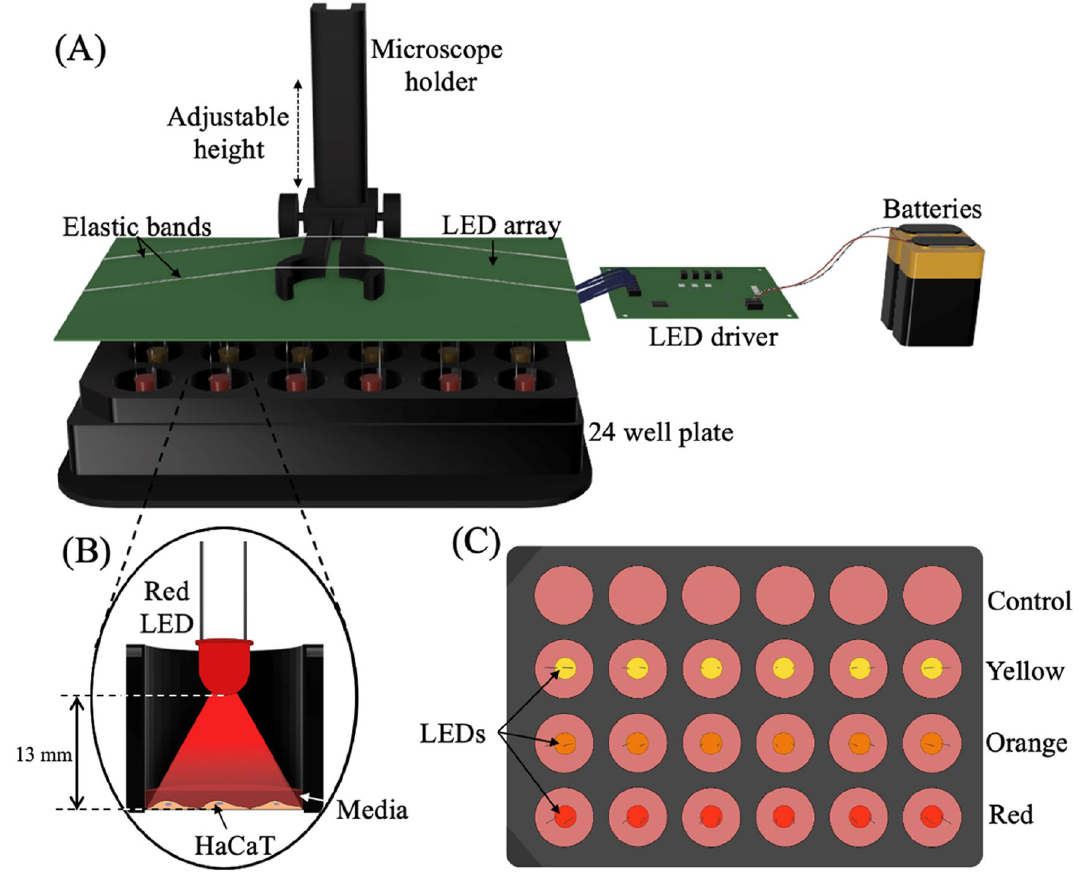
Figure 1. Visible light exposure system. ( A ) Schematic showing the experimental set up, comprised of an LED array, LED driver, two 9 V and one 1.5 V batteries, and a microscope holder to position the LEDs above an opaque 24-well plate. ( B ) Cross-section of the inside of a well demonstrating position of LED and visible light exposure. There is a 13 mm gap between the LED tip and the HaCaT monolayer. ( C ) Top-down view of the LEDs and 24-well plate. Multiple different wavelength LEDs and sham exposures can be run in parallel on a single plate. The configuration for the experiments described herein include a control/sham condition, yellow light (585 nm), orange light (610 nm), and red light (660